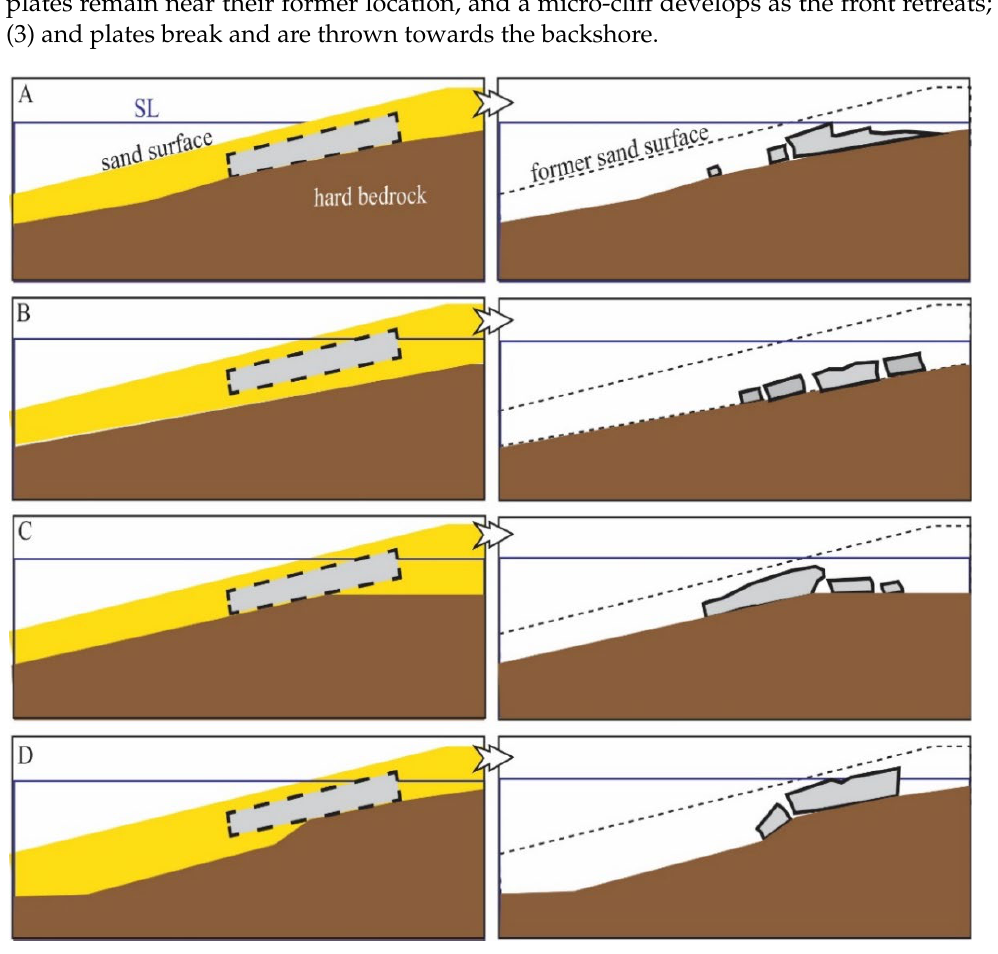
Figure 11. Erosion patterns of BR outcrops arranged by different underlying lithologies, assuming one stage of formation, and stable sea level. The illustrations on the left show initial stage: formation under sediment coverage. The illustrations on the right show the situation after erosion of the loose sediment and exposure of the BR outcrop; ( A ) (Scenario A) BR lens on hard substrate; ( B ) (Scenario B) BR lens on loose substrate; ( C ) (Scenario C) BR lens on hard surface on its sea side part and loose sediment on its land side part; ( D ) (Scenario C) BR lens on hard sub-surface on its land side part and loose sediment on its sea side part.